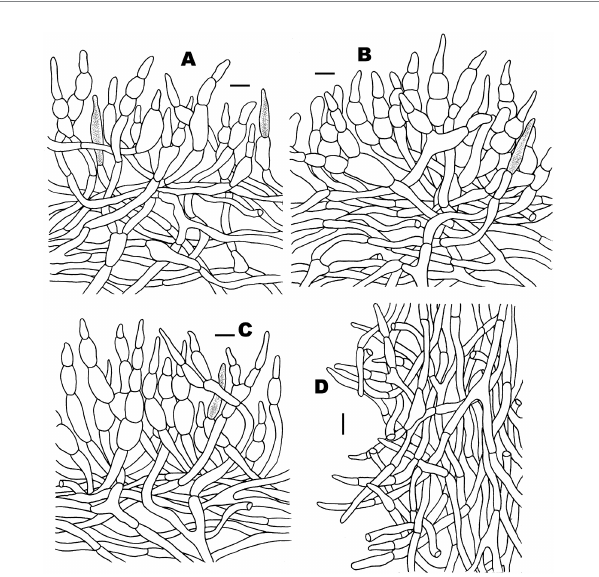
FIGURE 7 Microscopic features of Russula niveopicta (FHMU958, holotype). (A) Pileipellis at pileus center. (B) Pileipellis at the middle part between the center and margin of the pileus. (C) Pileipellis at pileus margin. (D) Stipitipellis. Scale bars = 10 μ m. Drawings by Y. X.